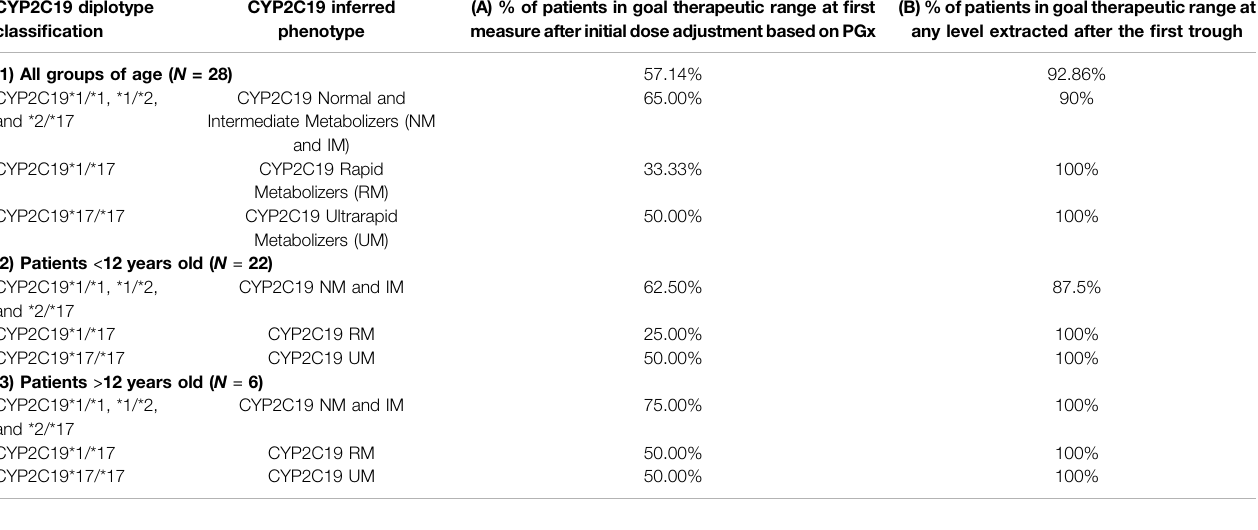
TABLE 2 | Percentageofpatientsinthegoaltherapeuticrange(1 – 5,5 μ g/ml)by CYP2C19 diplotypeinour study cohortincluding1)allgroupsofage,2)patients < 12yearsold, and3)patients > 12yearsold.(A)FirsttroughlevelmeasureafterinitialdoseadjustmentbasedonPGx.(B)Levelwithingoaltherapeuticrangemeasuredafterthe fi rsttrough. CYP2C19 diplotype CYP2C19 inferred classi fi cation phenotype